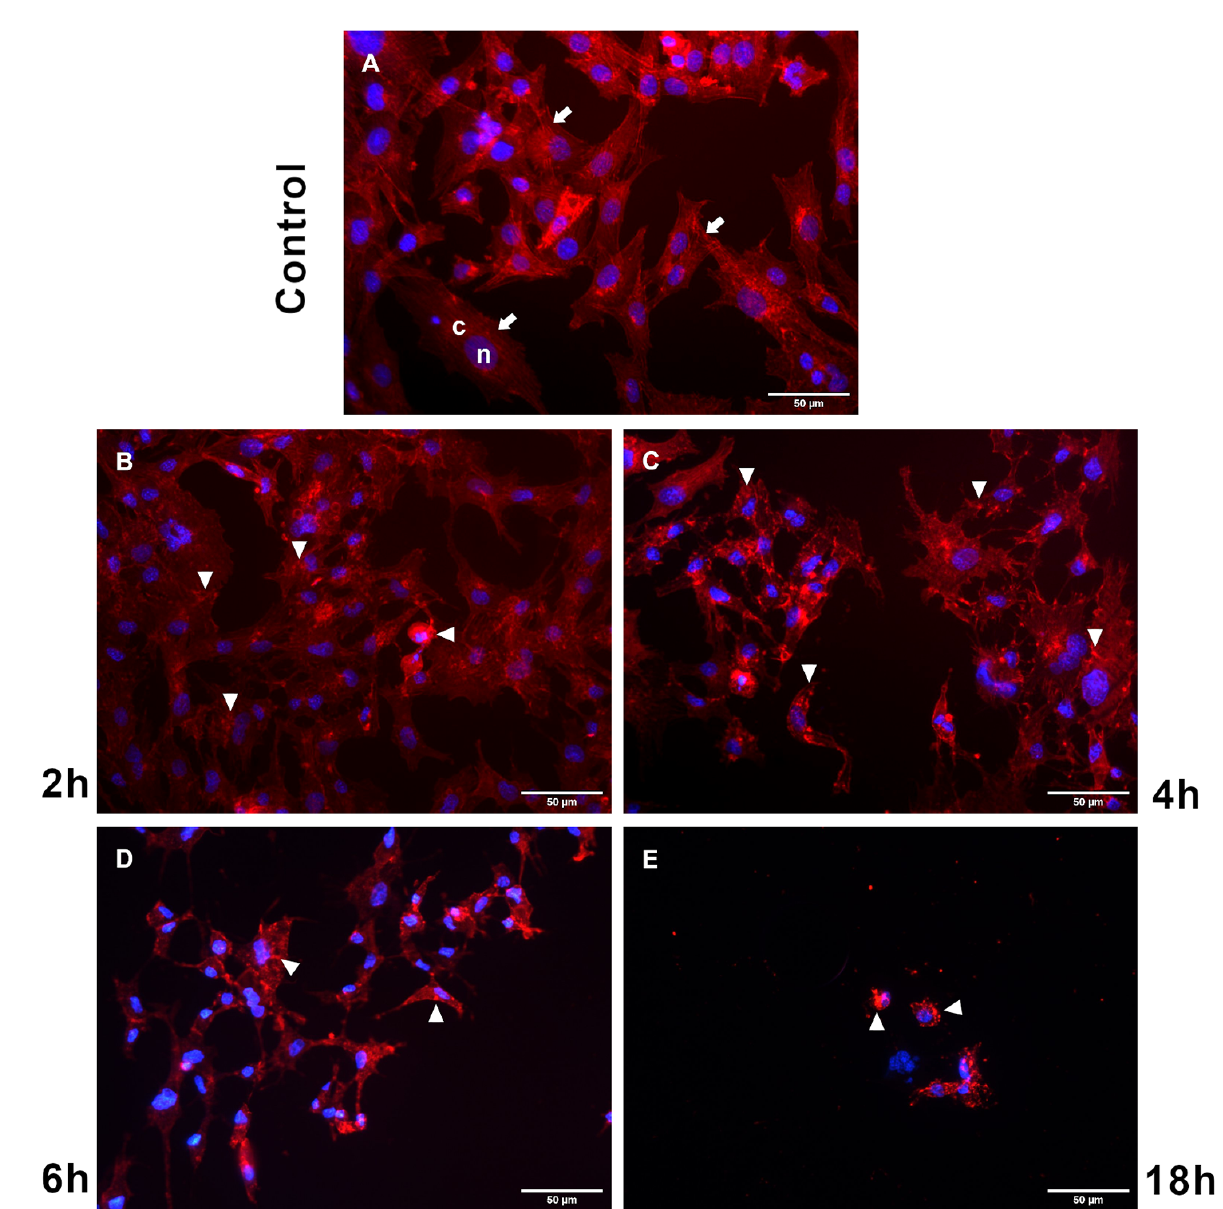
Figure 1. Alterations in cell morphology due to the contraction of the actin filaments. (A) CEC-32 cells without ECVF, 24 hours. (B, C, D and E) CEC-32 after ECVF incubation for 2, 4, 6, and 18 hours, respectively. Red: Phalloidin-TRITC; blue: DAPI. Arrows indicate normal actin filaments and arrowheads indicate contracted actin filaments. Scale bars = 50